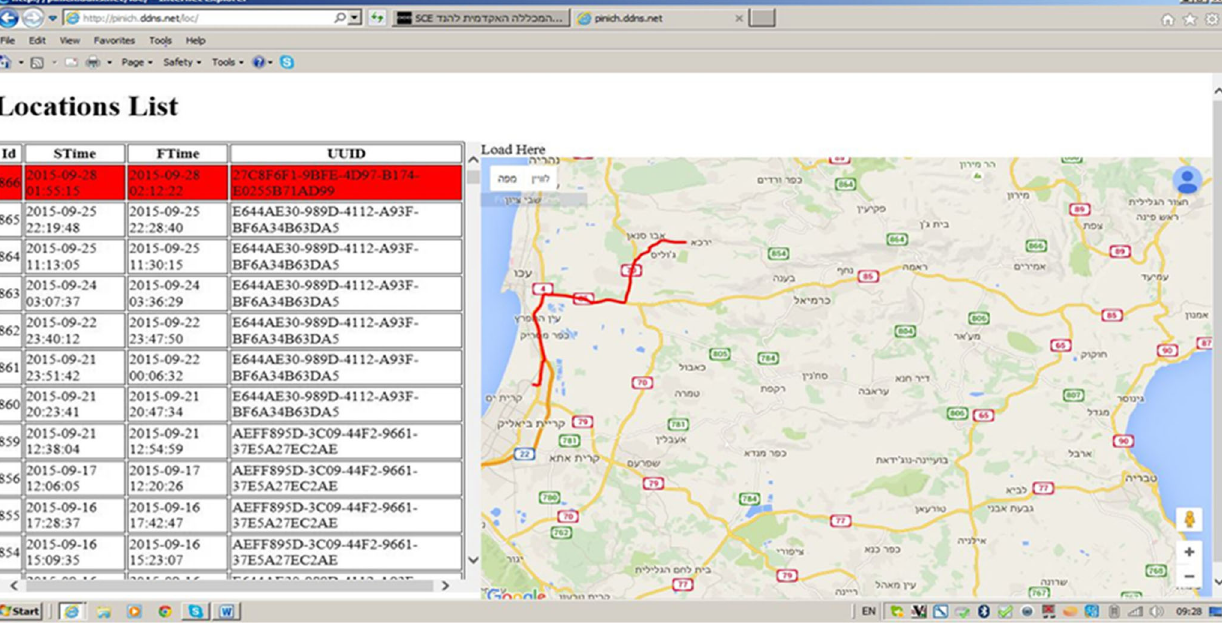
Fig. 1 Sample of the Get Location application